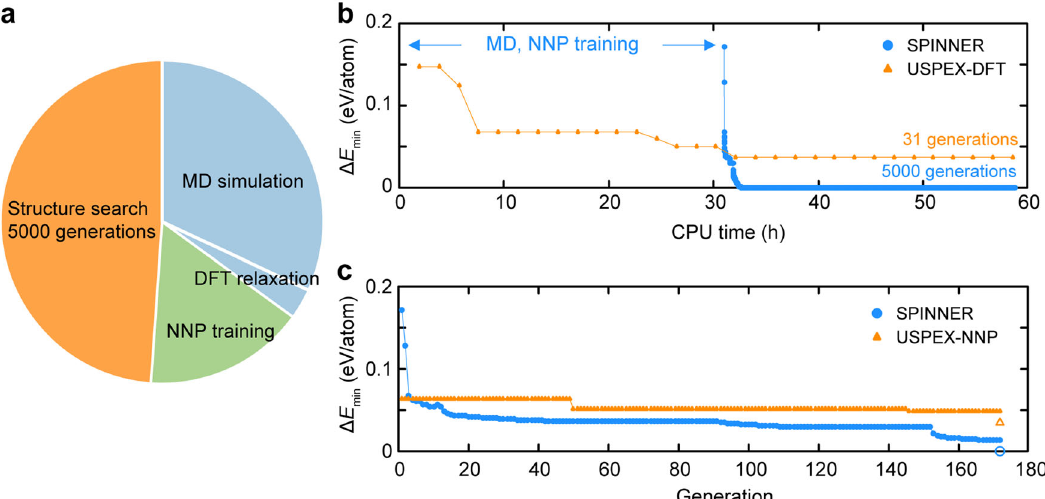
Fig. 4 Computational ef fi ciency of SPINNER. a Schematic diagram showing the relative time spent on each step for Mg 2 SiO 4 . b Comparison of the SPINNER to the USPEX code with DFT calculations in the case of Mg 2 SiO 4 . In the Figure, Δ E min of SPINNER and USPEX are evaluated by NNP and DFT, respectively. c Comparison of the SPINNER to the USPEX code with NNP calculations. Δ E min of fi lled points are calculated by NNP and the empty points are the lowest DFT energies among the structure candidates within an energy window of 50